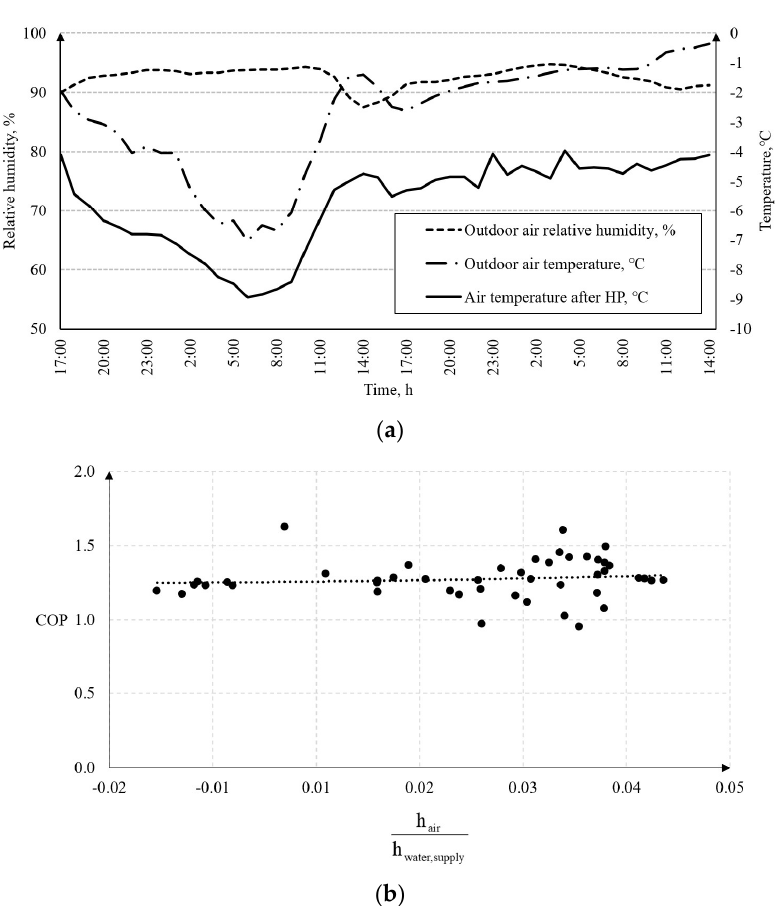
Figure 8. ( a ) Variation in ambient air parameters and temperature after ASHP evaporator; ( b ) variation in the COP de- pending on the ratio of enthalpies of ambient air and water supplied (1–3 December 2020). ( b ) variation in the COP depending on the ratio of enthalpies of ambient air and water supplied